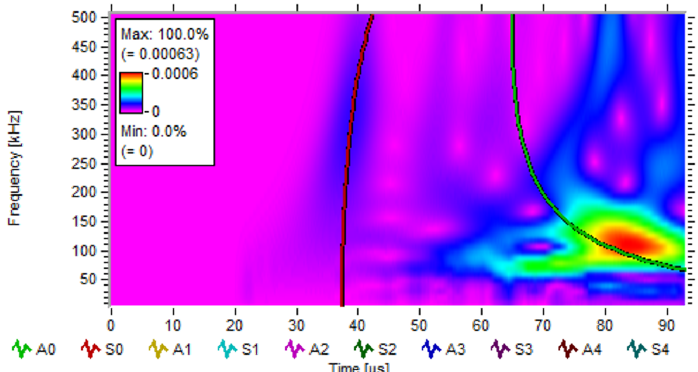
Figure 9. Wavelet transforming diagram of the signal in stiffened plate.